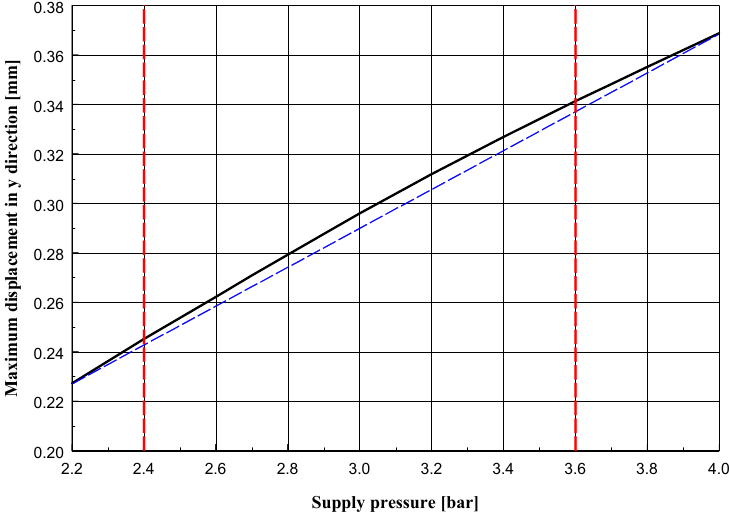
Figure 13. Maximum displacement in sand layer (middle section) in y direction parallel to roller axis depending on pressure in supply line.